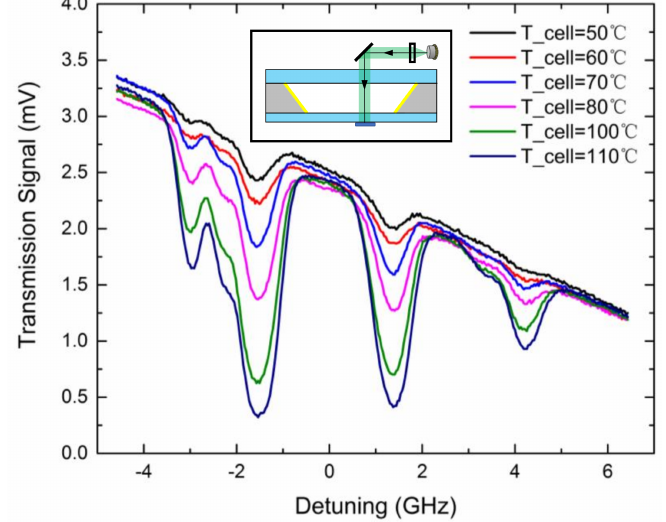
Figure 7. Through-cell absorption spectroscopy of rubidium D1 transition at different temperatures and the through-cell optical configuration